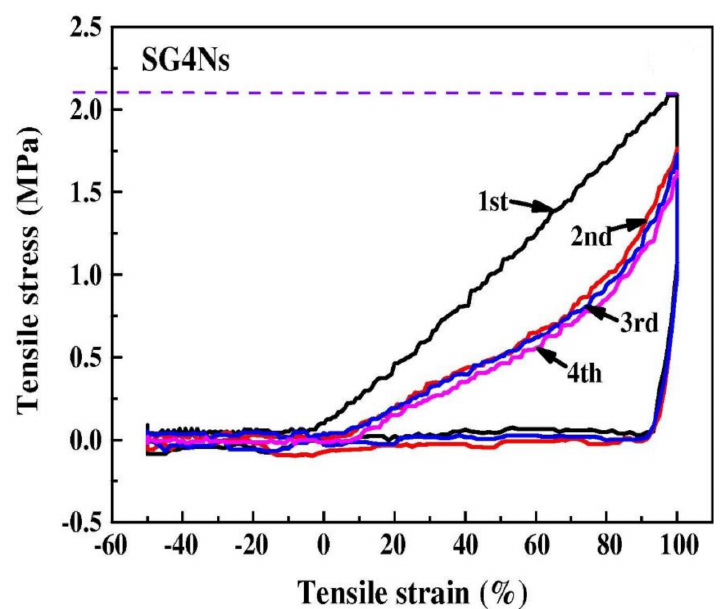
Figure 14. Average fixation-ratio of SMPU/GO nanofibrous mats during cyclic-tensile test resembling shape-memory effect. Reproduced with permission from